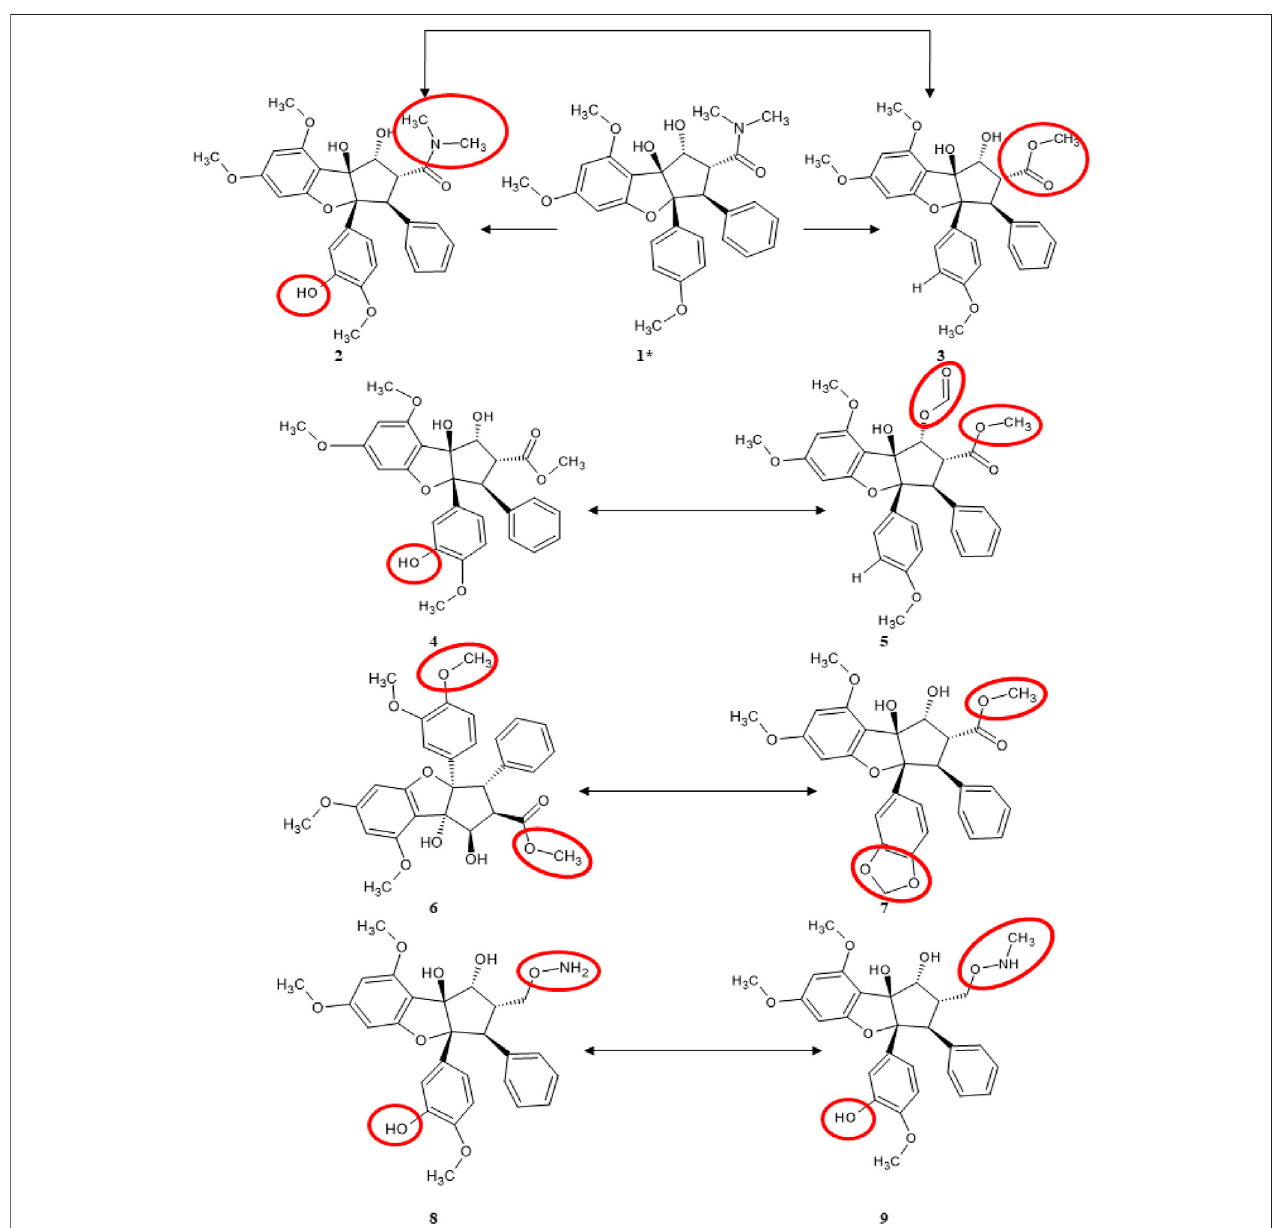
FIGURE 8 | Structural differences between most similar compounds of training set. The red circles indicate which functional groups are exchanged. 1* corresponds to Roc-A (pivot